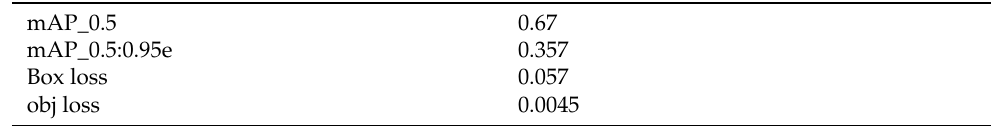
Table 5. Validation on SEAGULL—optimal values of